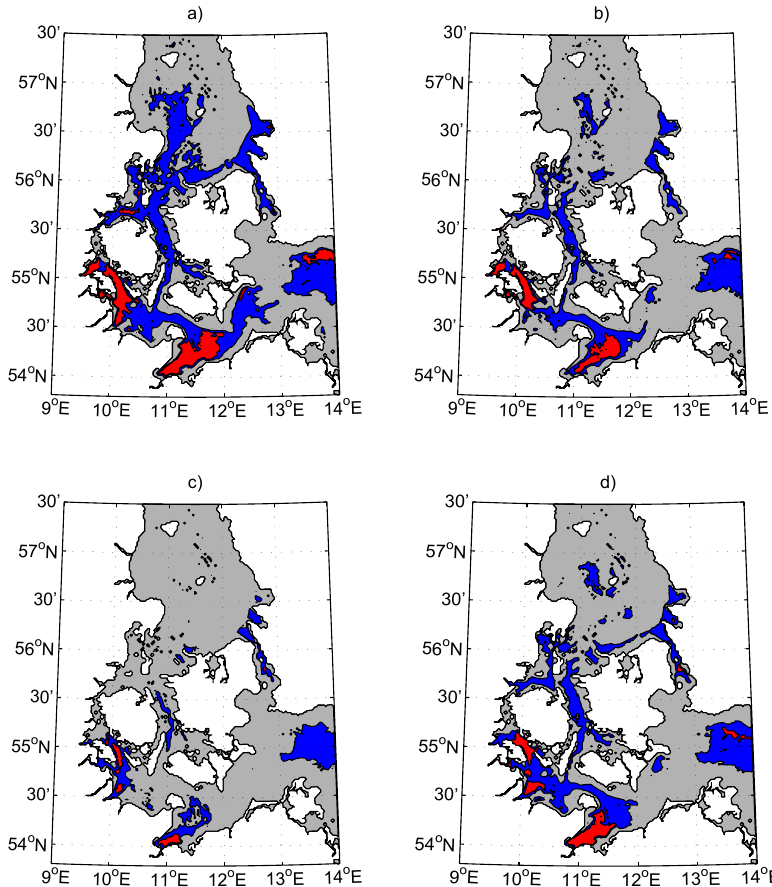
Fig. 9. Monthly averaged bottom DO concentration for (a) September 2002 and (b) September 2002 with increased wind and (c) September 2004 and (d) September 2004 with decreased wind. Red and blue patches indicate areas with hypoxia ( < 63µmoll − 1 ) and oxygen deficiency ( < 126µmoll − 1 ) respectively.